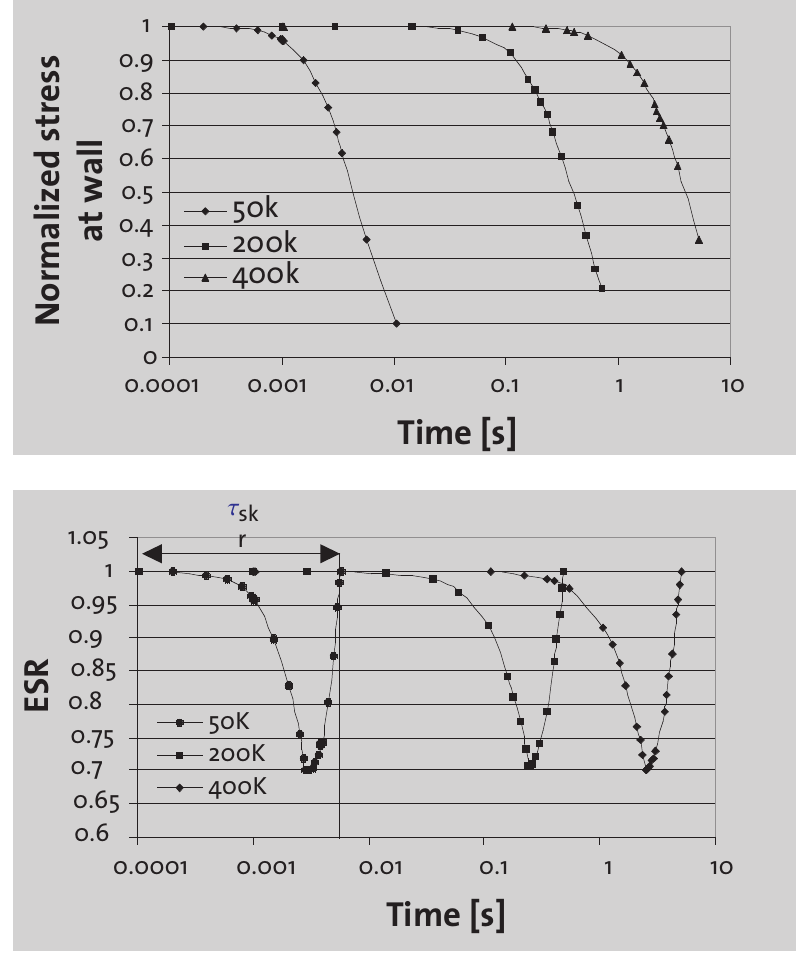
Figure 6 (right above): Stress relaxation of three different molecular weight polybutadiene Figure 7 (right below): Simulated stress fluctuations at the die exit for polybutadiene